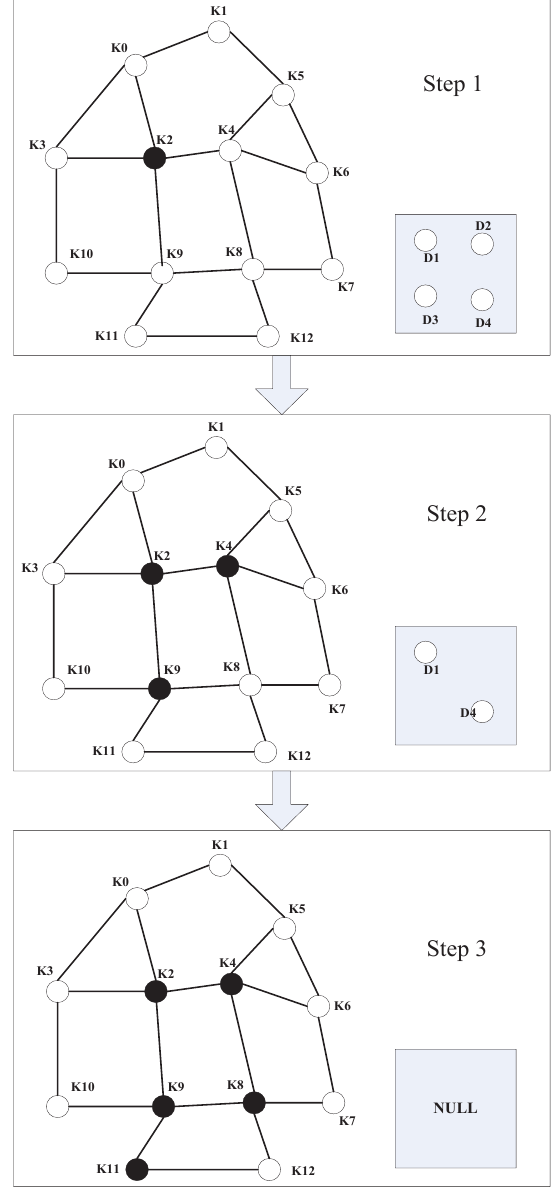
Figure 8. Example of the Recursion Matching (RM)